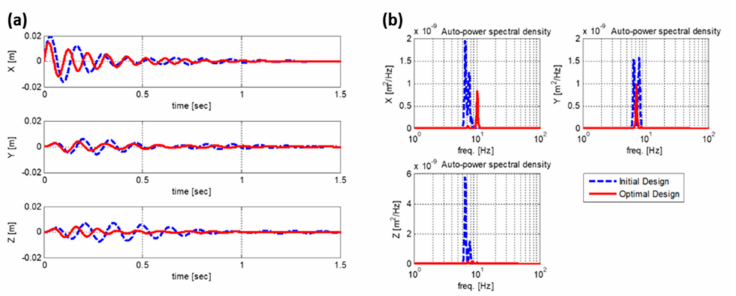
Figure 11. Simulation results of the coupled three-DOF mathematical model between initial and optimal designs in ( a ) the time domain and ( b ) the frequency